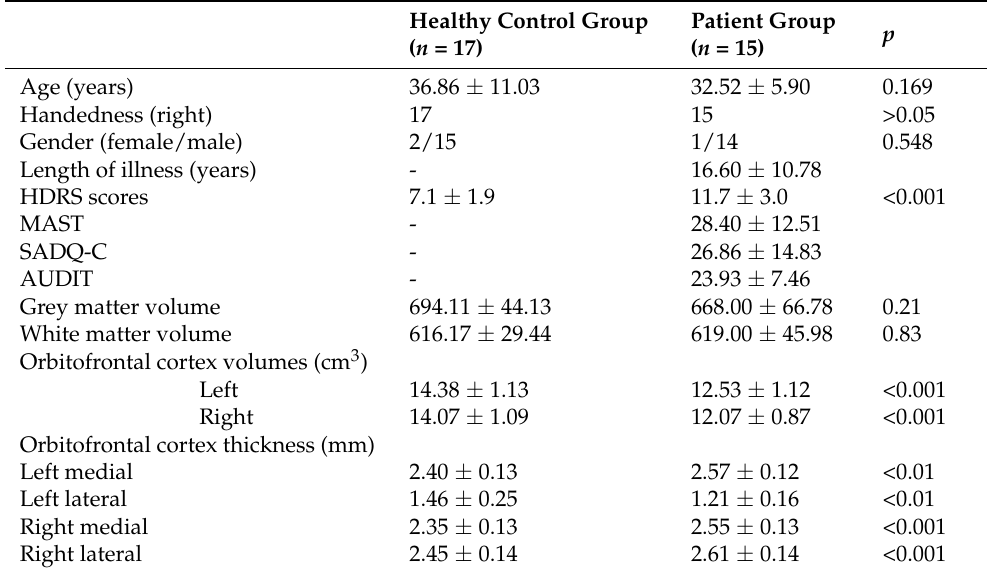
Table 1. Demographic, clinical, and orbitofrontal cortex volumes data in patients and the control group.